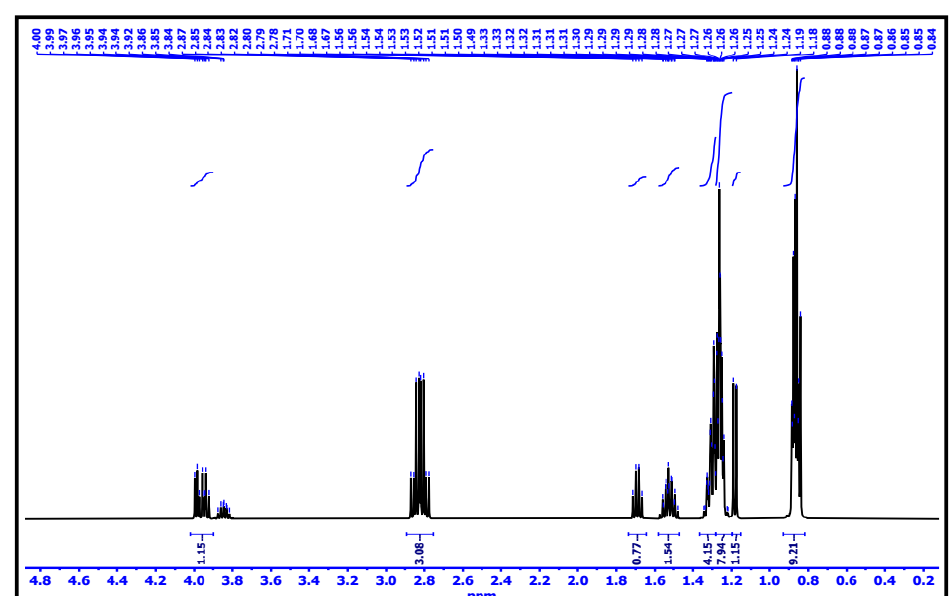
Figure 4. Characterization of the PPVP composite by 1 H-NMR spectrometry.